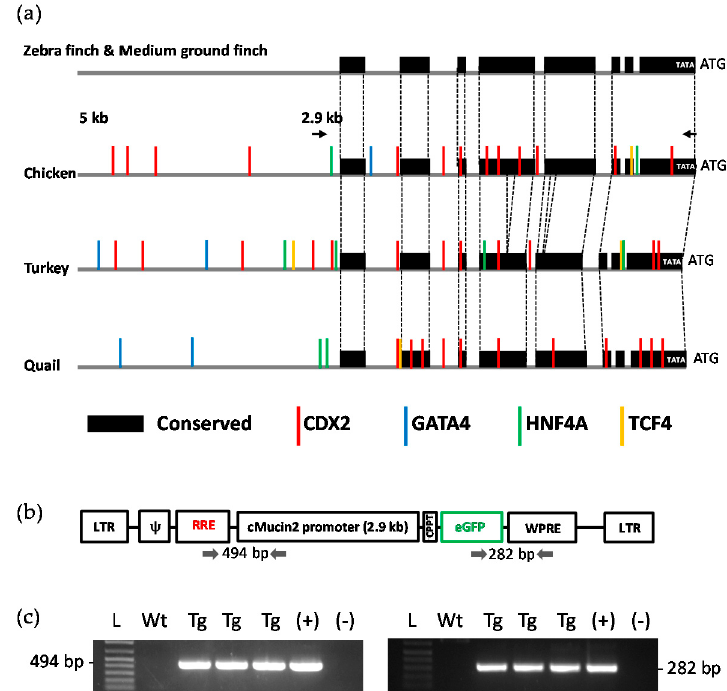
Figure 2. ( a ) Prediction of the distribution of binding sites for an intestine-specific transcription factor. The binding sites of intestine-specific transcription factors (e.g., CDX2 (red), GATA4 (blue), HNF4A (green), and TCF4 (yellow)) are highlighted on the promoter region of the MUC2 gene from chicken, turkey and quail. Highly conserved DNA sequences between avian species are marked with a black box; ( b ) Viral vector construct. Construct contains 2.9 kb chicken MUC2 promoter. Located downstream of the promoter is eGFP; ( c ) Confirmation of two primer sets. Two primer sets were utilized to confirm the presence of the transgene in animals. L (DNA ladder), Wt (wild-type), Tg (transgenic quail), + (positive control), − (negative control).